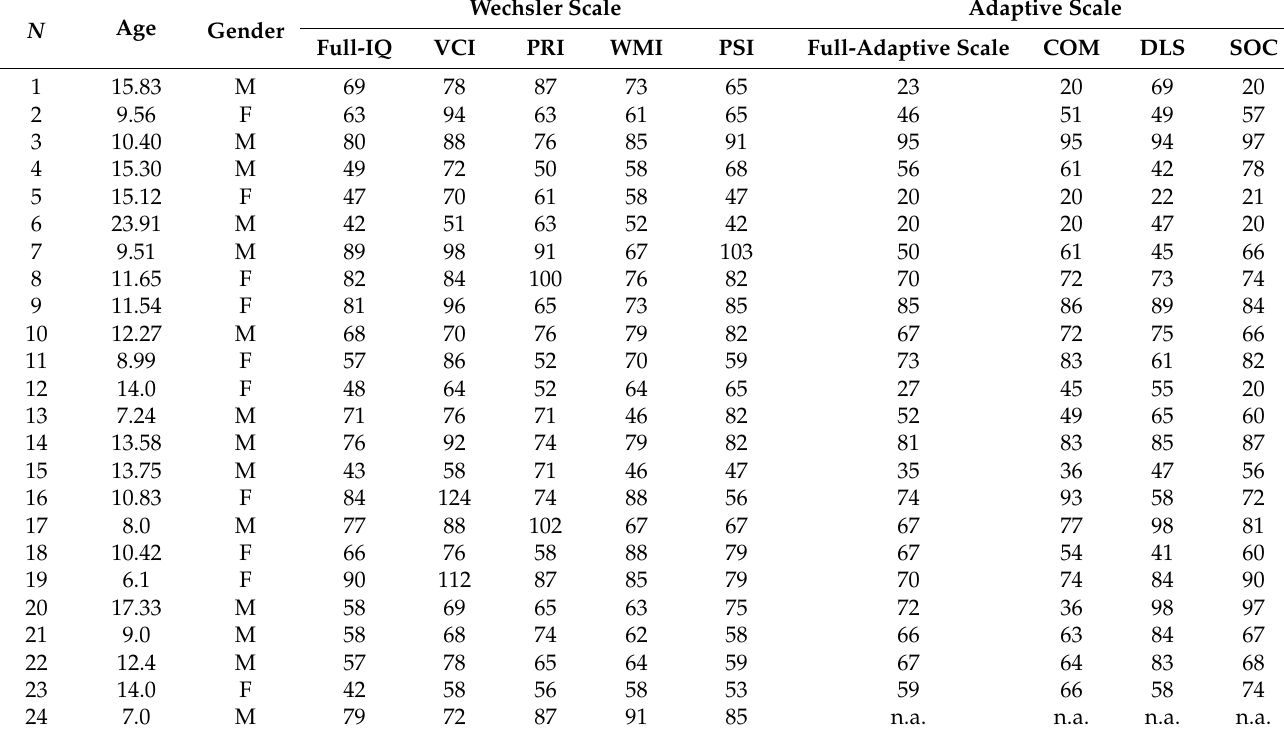
Table 1. Demographic features, cognitive abilities, and adaptive behaviour of studied